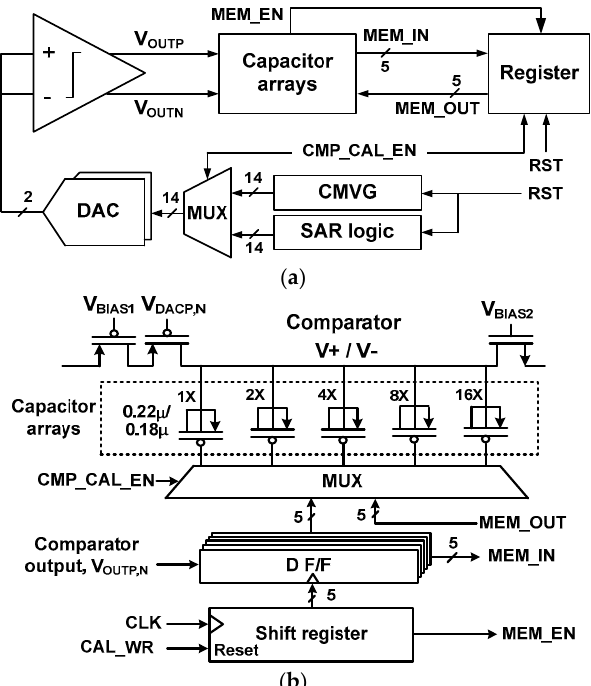
Figure 4. ( a ) Block diagram for comparator offset calibration, ( b ) Control block for the binary-weighted capacitors.